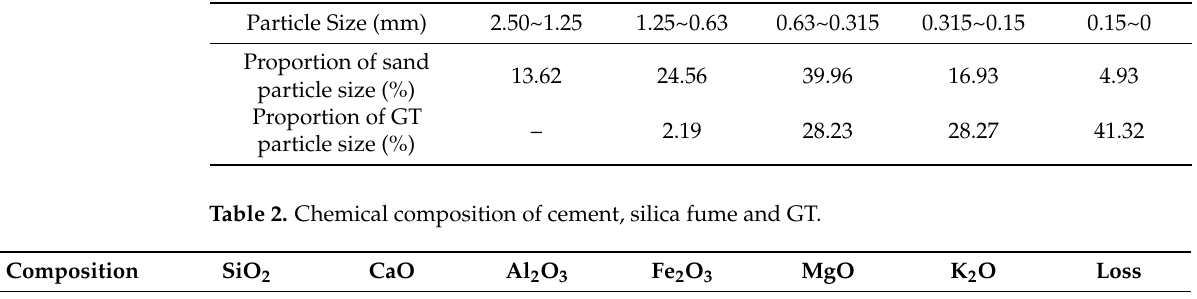
Table 1. Comparison of particle size between sand and GT.